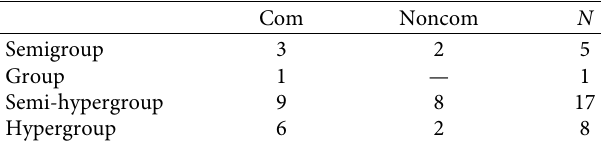
Table 2: Classification of the semi-hypergroups of order